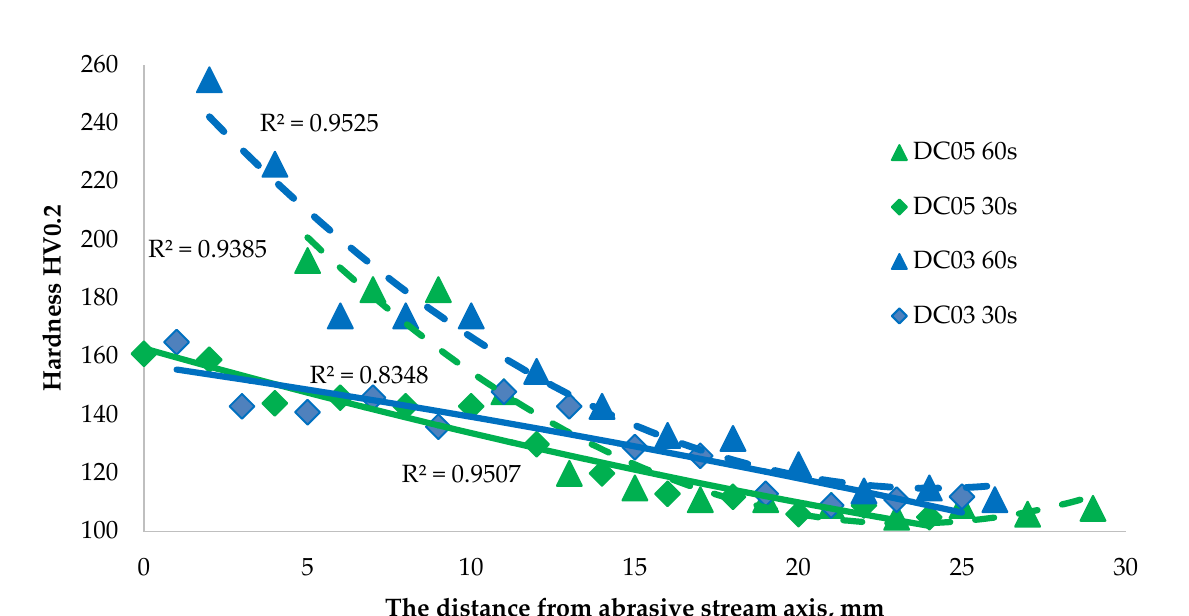
Figure 13. Hardness of the investigated steel cross-section in relation to the distance of the sample from the axis of the abrasive stream.